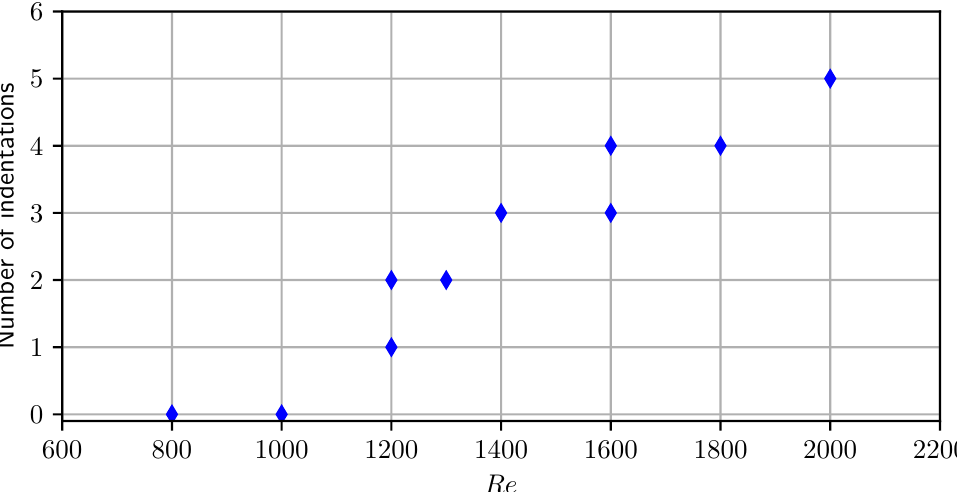
Figure 11. Explored map in the inlet cavitation number—outlet cavitation number ( σ 1 symbols stand for different Reynolds numbers. The arrows are guides to the eye.